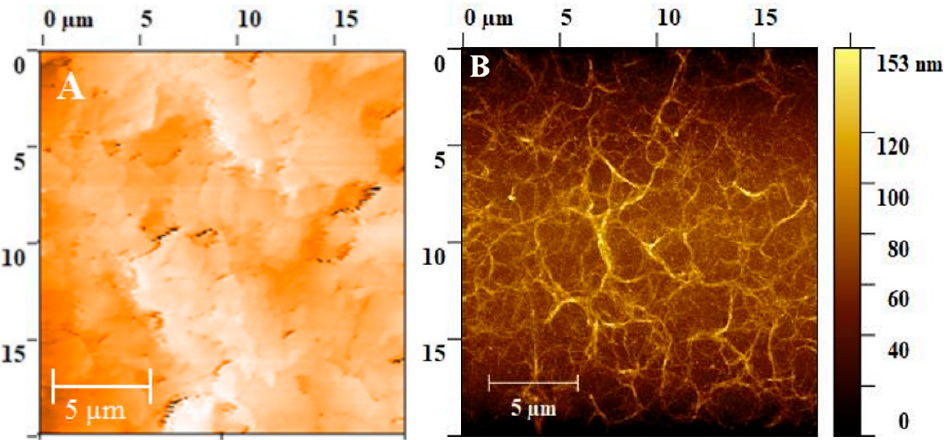
Figure 3. Atomic force micrographs (AFM) of the electrode: ( A ) unfunctionalized Ag electrode and ( B ) functionalized electrode with SWCNTs.